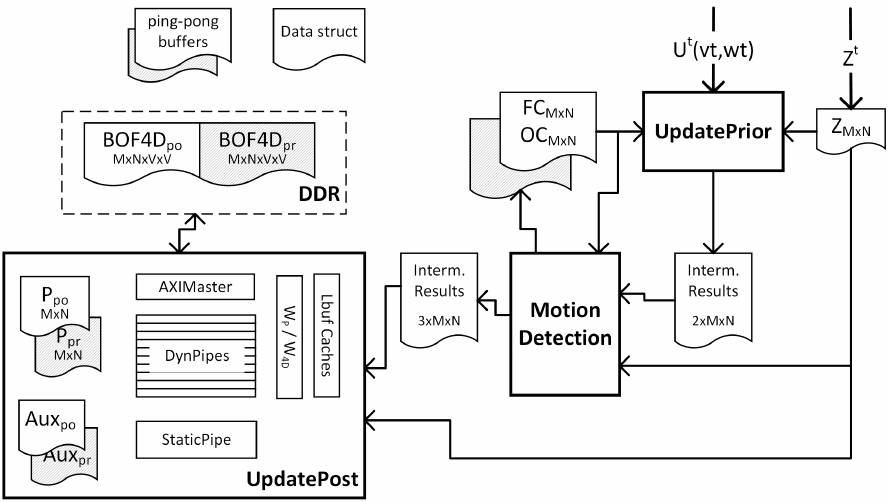
Figure 10. Main blocks of the FPGA